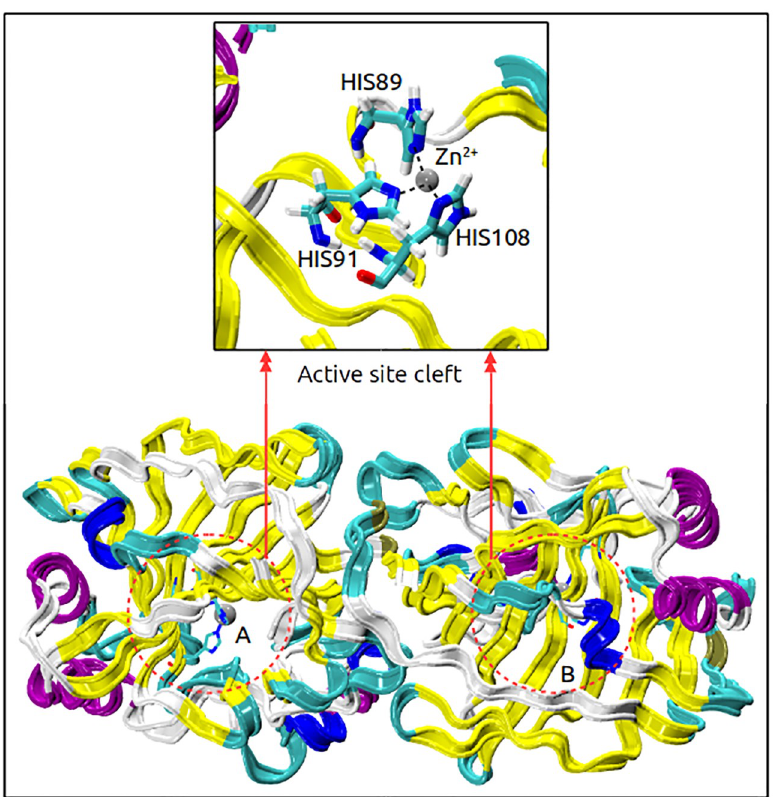
Fig 1. Dimeric structure of thermostable SazCA. Structural representation of dimeric SazCA analysed in this study. The dimer is shown with two chains A, B in Ribbon representation. Zn 2+ ions are shown as grey spheres and histidine residues involved with direct interactions (active site cleft) with Zn 2+ are shown in Licorice representation. α -helices are shown with violet color, 3 10 -helices with blue color, β -sheets with yellow color, loops (turns and coils) are shown in white and cyan